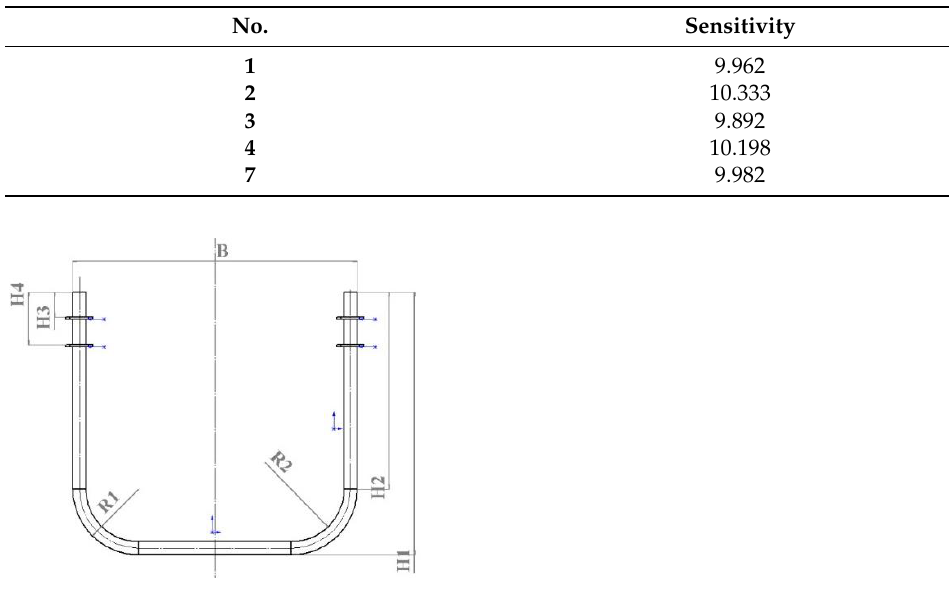
322 323 Figure 9. Response spectrogram of CMF double-beam coupled vibration model without additional